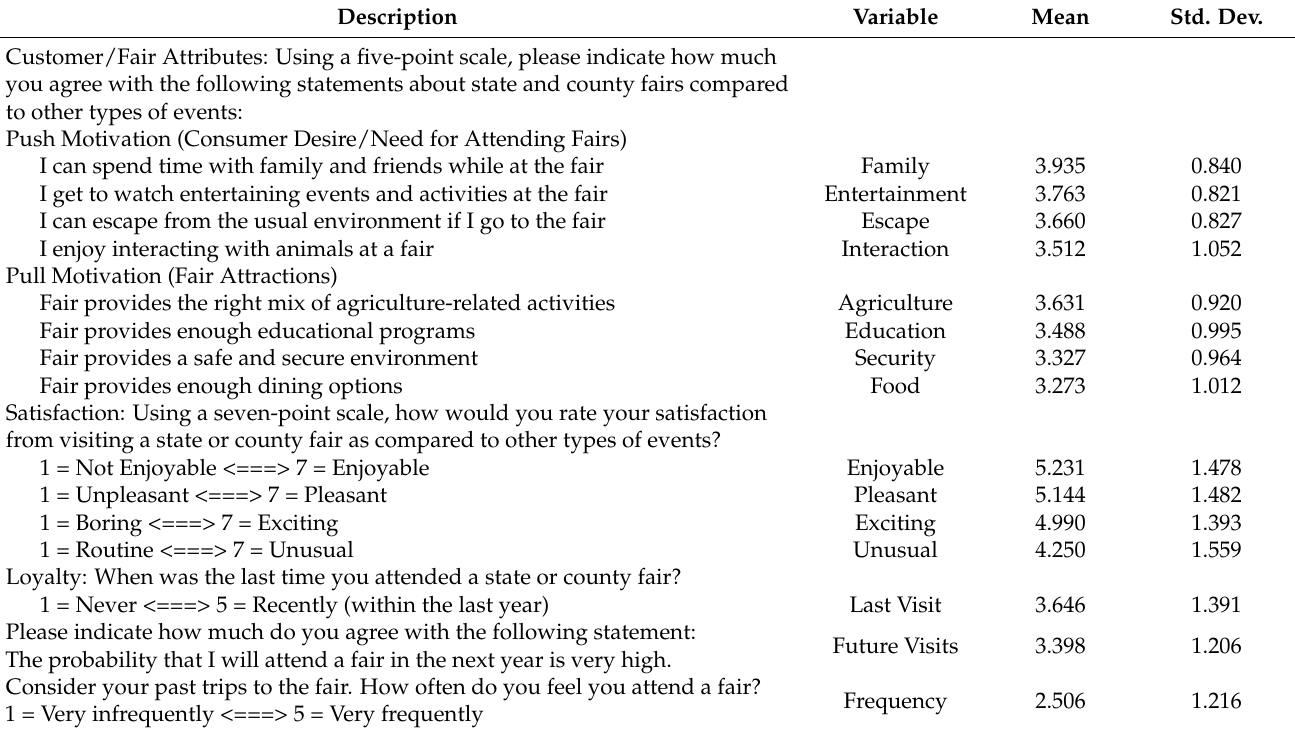
Table 2. Survey questions and descriptive statistics for variables included in the